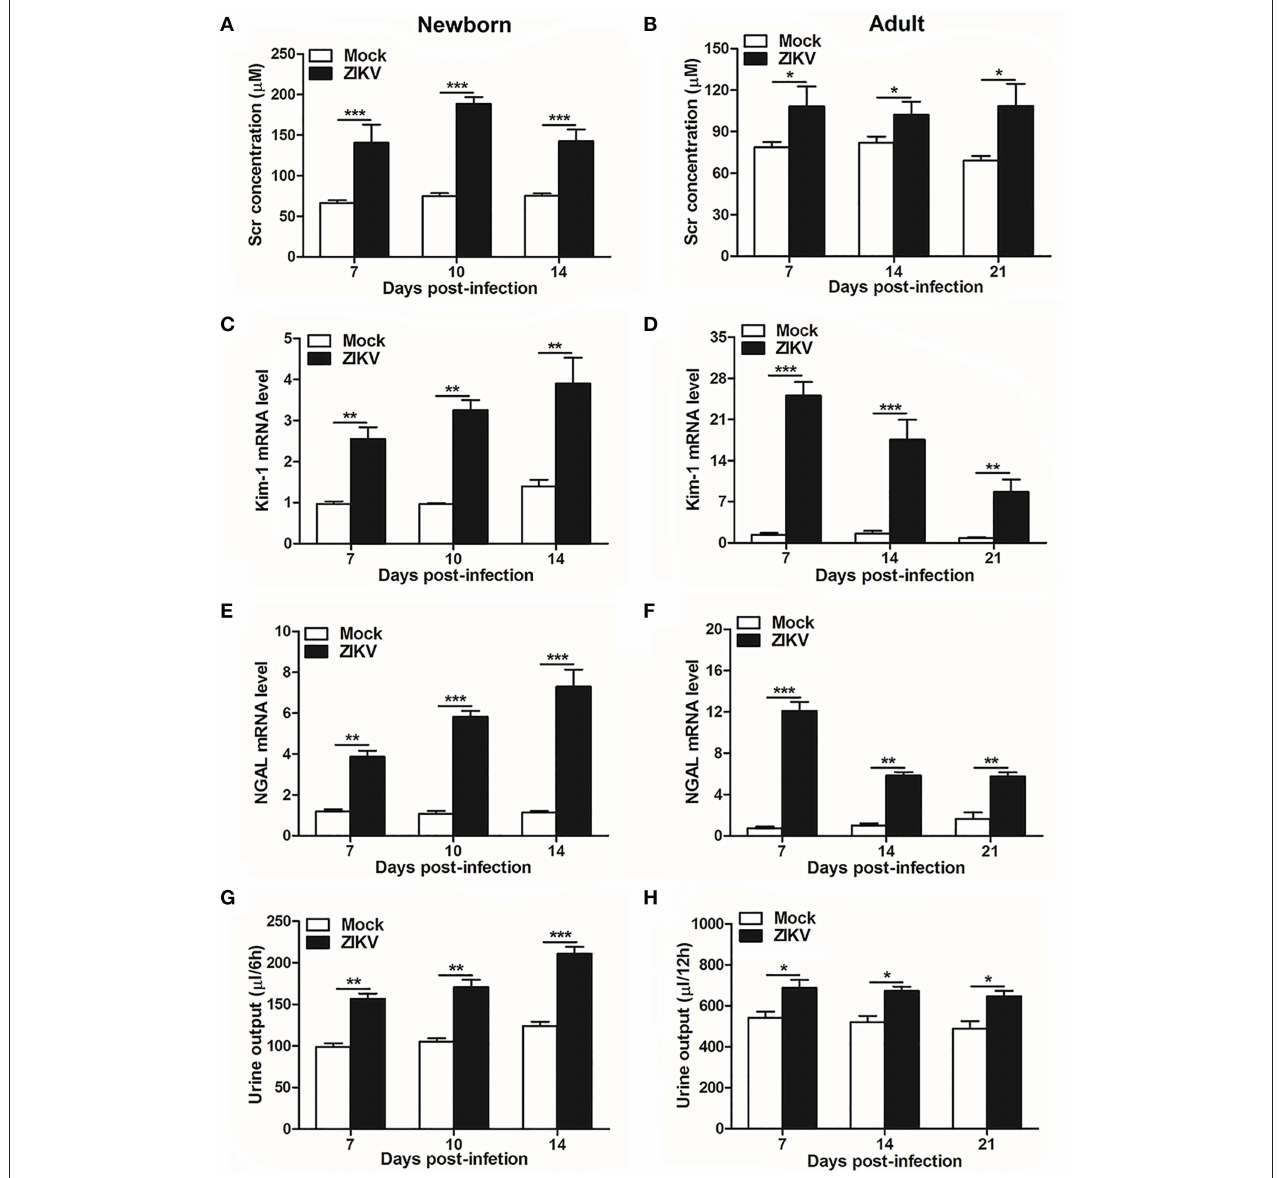
FIGURE 2 | Acute kidney injury in ZIKV-infected newborn and adult mice. (A,B) The Serum creatinine (Scr) concentration was tested in newborn mice (A) at 7, 10, 14 days post-infection and in adult mice (B) at 7, 14, 21 days post-infection using a creatinine assay kit (BioAssay Systems). (C–F) The relative mRNA levels of KIM-1 (C,D) and NGAL (E,F) were determined in the kidneys of newborn mice (E) at 7, 10, 14 days post-infection and adult mice (F) at 7, 14, 21 days post-infection by qRT-PCR. (G,H) Urine output was measured for 6h in newborn mice (G) and 12h for adult mice (H) . Data were presented as mean ± SEM ( n = 6), * p < 0.05, ** p < 0.01, *** p < 0.001 vs. mock